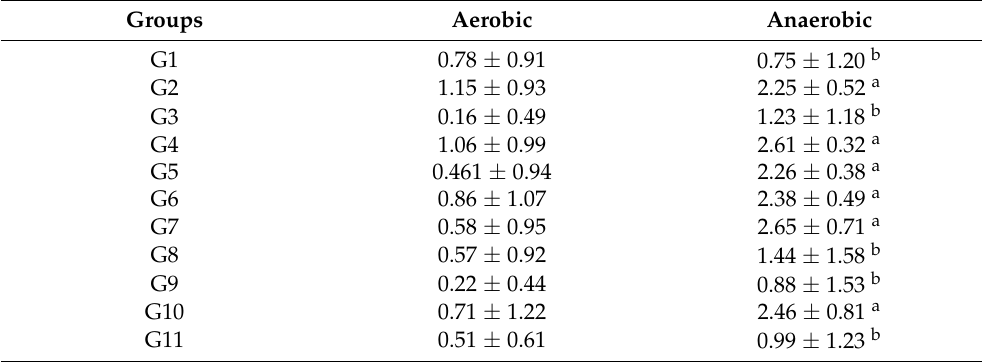
Table 3. Means (Log 10 CFU/g) of bacterial quantification in aerobic and anaerobic present in the liver of birds of different groups.